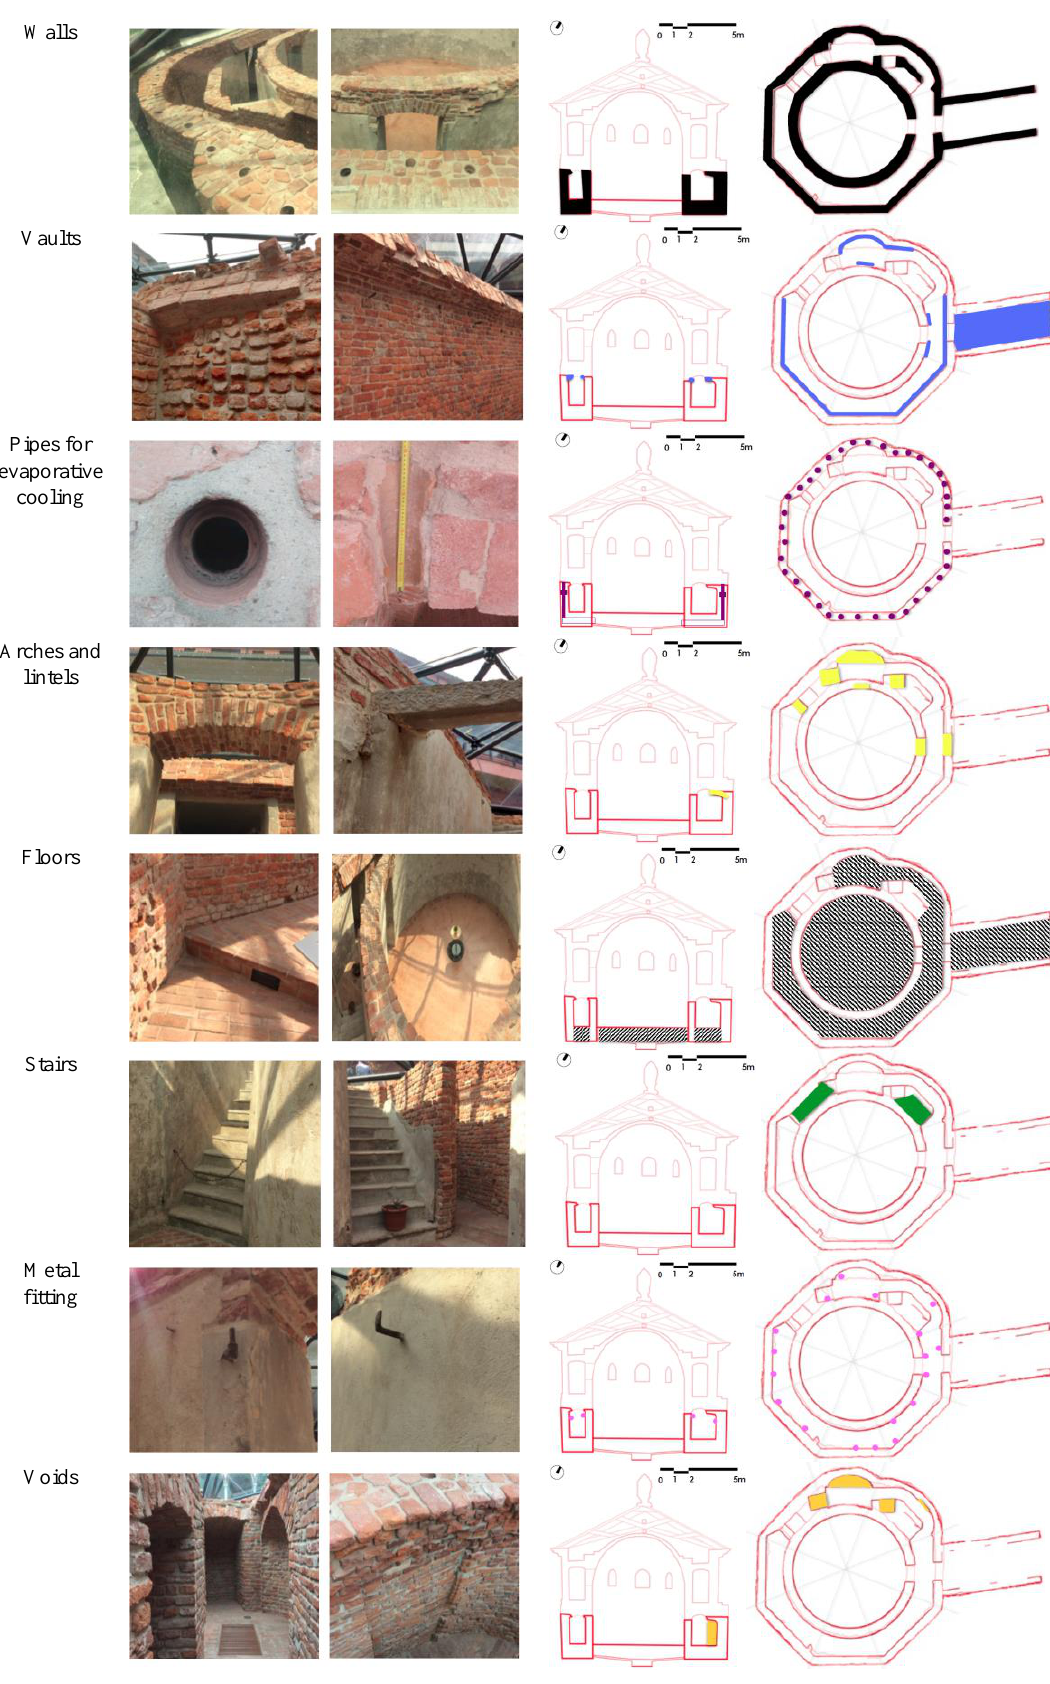
Fig. 6. The different elements of the ice house, classified in different families and modelled using BIM technology.